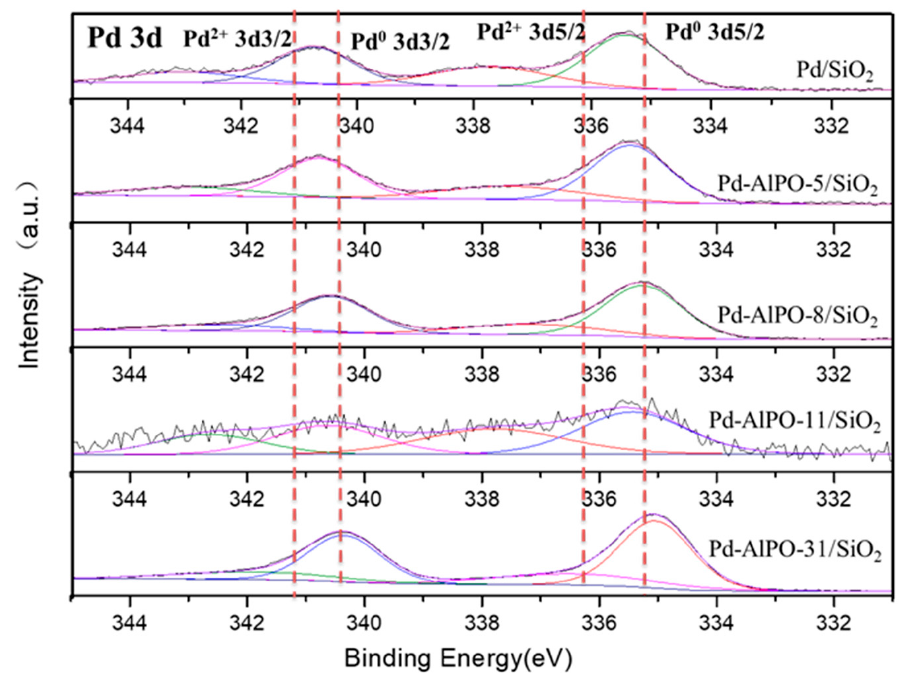
Figure 9. Pd 3d XPS spectra of reduced catalysts.